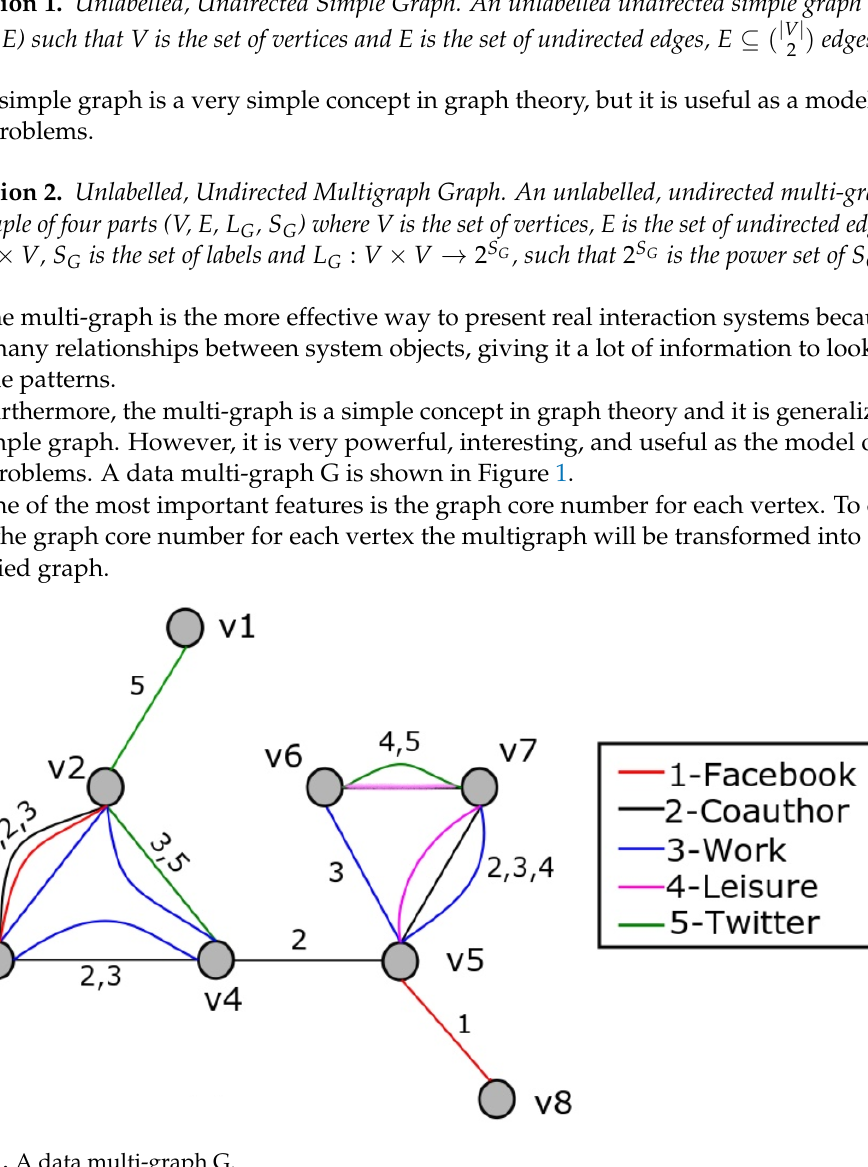
Figure 1. A data multi-graph